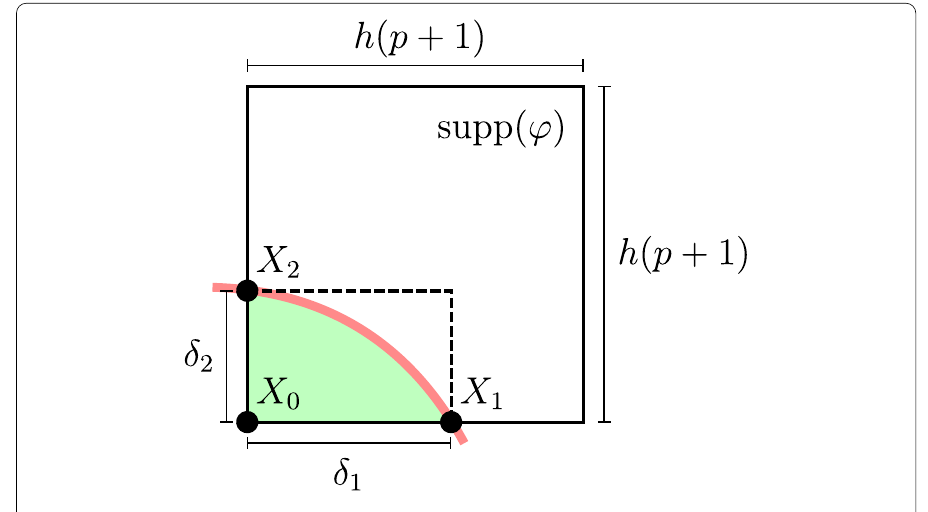
Fig. 3 Illustration of the geometric quantities used in intersection conditions (51) in energy norm and (96) in max